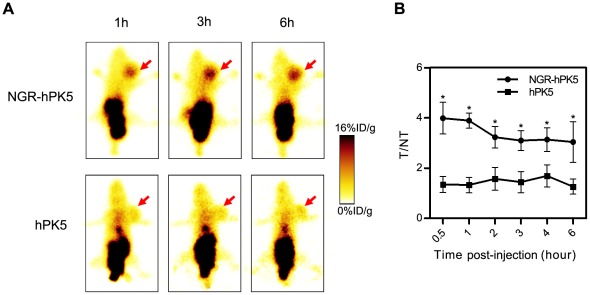
Detection of hPK5 and NGR-hPK5 in tumor localization by planar imaging analysis.When the LLC tumor volume reached about 300–400 mm3, 99 mTc-labeled hPK5 or NGR-hPK5 (500 µCi) were injected i.v. into LLC grafting C57BL/6J mice. Planar images were acquired in the prone position at 0.5, 1, 2, 3, 4 and 6 hours post-injection. A
, Representative images from the planar imaging of 99 mTc-NGR-hPK5 and 99 mTc-hPK5 at 1, 3 and 6 hours post-injection. (arrows LLC tumors) B
, The tumor-to-contralateral normal tissue (T/NT) ratios were calculated from the ROI analysis. N = 5. * p<0.05 compared with hPK5.